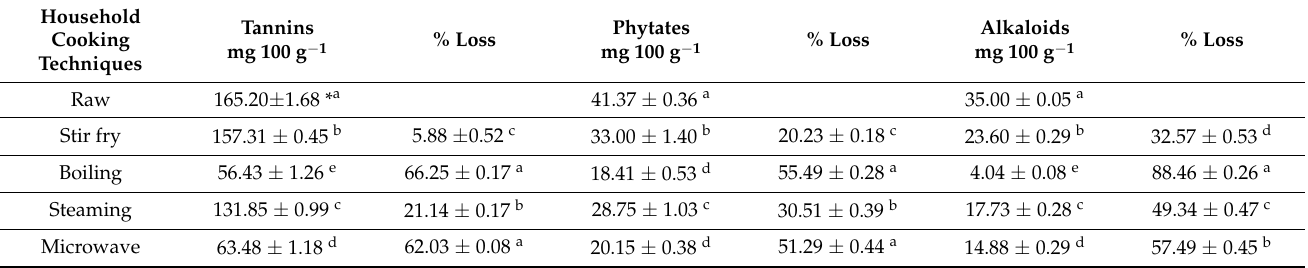
Table 4. Effects of household cooking techniques on antinutritive compounds present in African pumpkin leaves ( Momordica balsamina